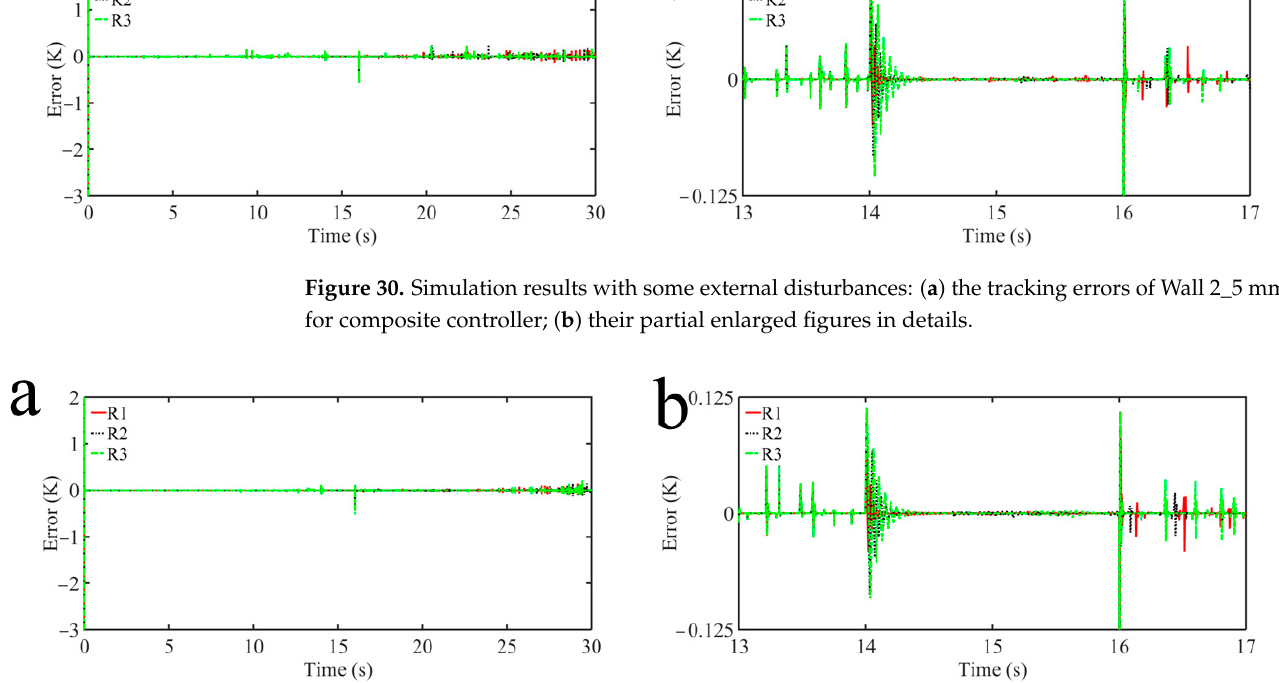
Figure 31. Simulation results with some external disturbances: ( a ) the tracking errors of Wall 2_45 mm for composite controller; ( b ) their partial enlarged figures in details.